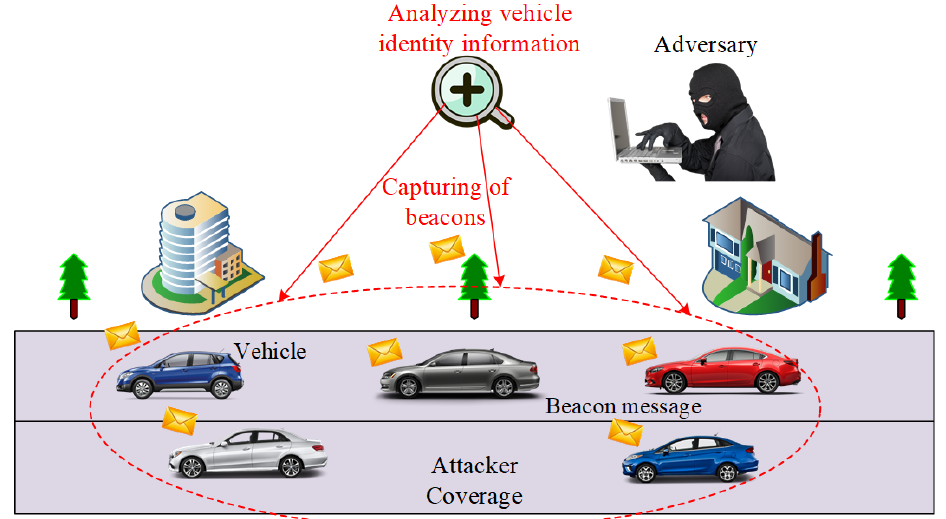
Figure 3. Adversary